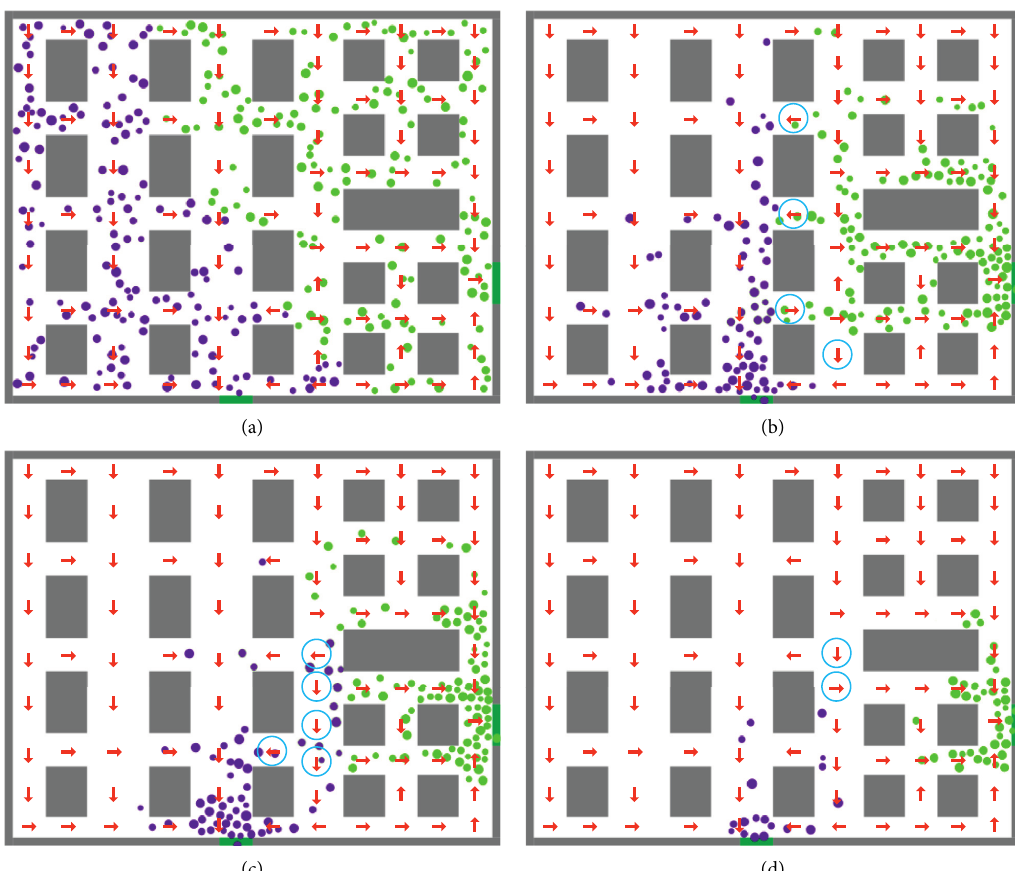
Figure 6: Snapshots of simulation at different simulation time intervals: (a) t � 0s; (b) t � 26.31 s; (c) t � 47.66s; (d) t �